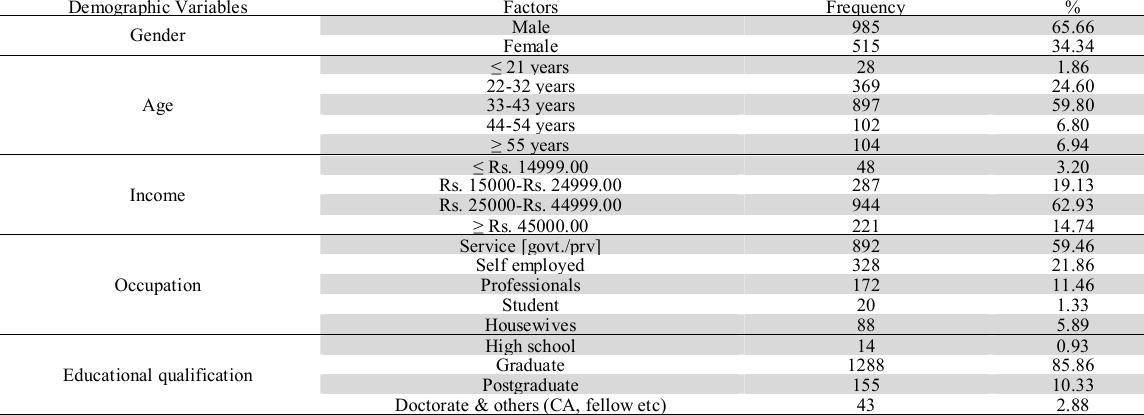
Demographic data of the respondents Demographic